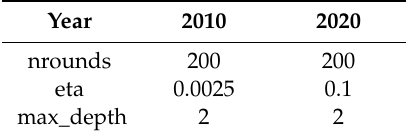
Figure A2. Scatter plot of accuracy obtained by utilized all range of hyperparameter of XGBoost function tuning the model: ( a ) for 2010 LC map ( b ) for 2020 LC map. Table A1. Best hyperparameters for XGBoost classifier.